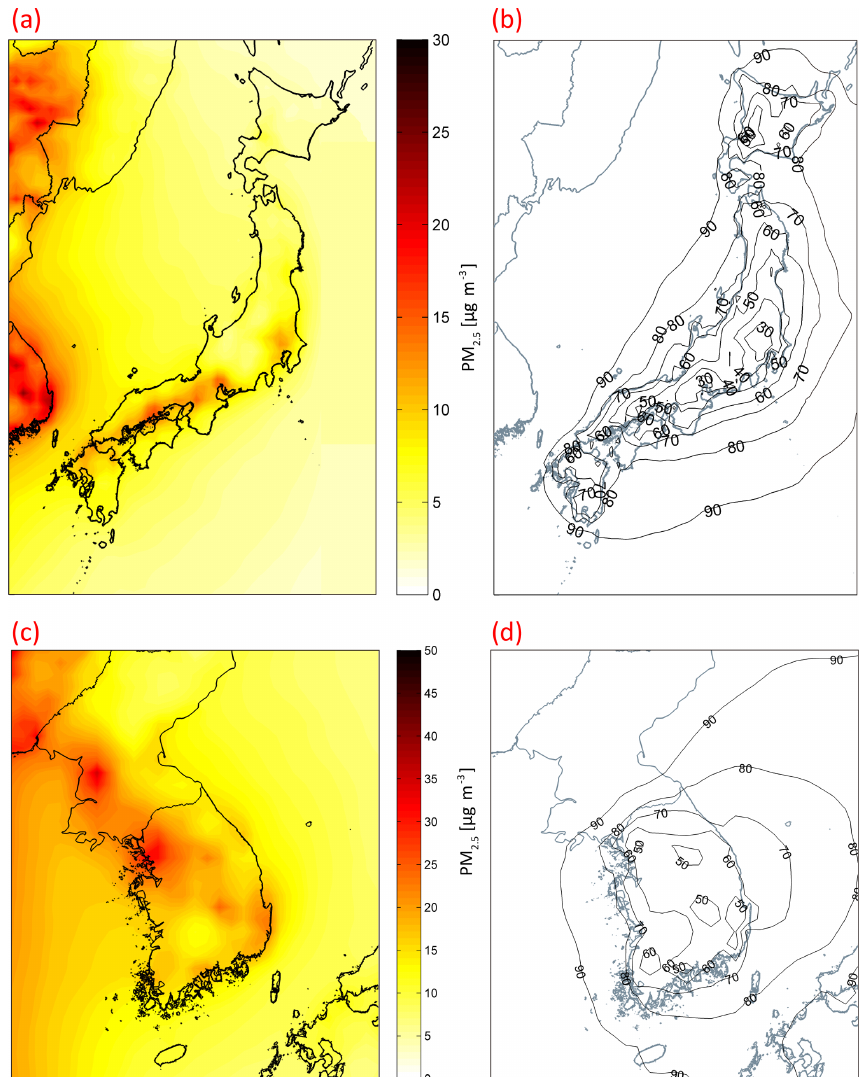
Figure 3. The modeled annual average surface PM 2 . 5 (µgm − 3 ) over (a) Japan and (c) South Korea in 2010 and the percentage (%) of total PM 2 . 5 due to transboundary air pollution over (b) Japan and (d) South